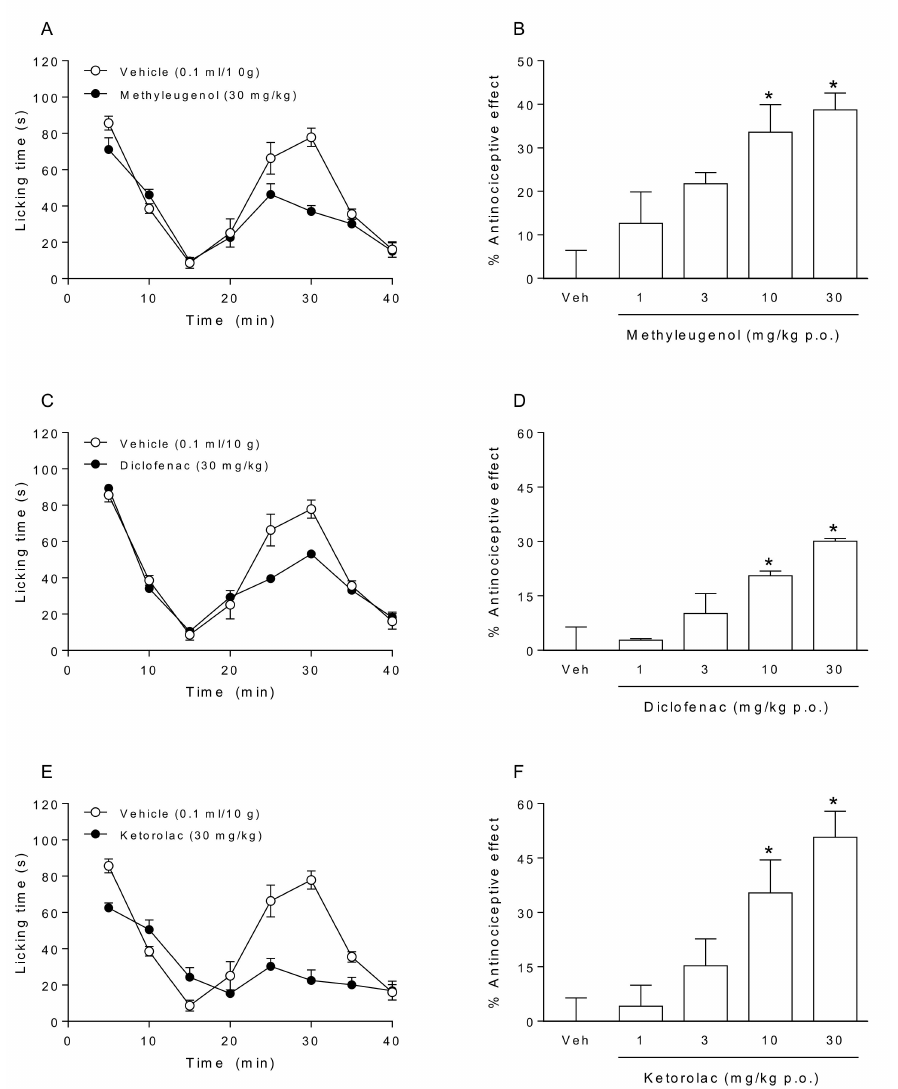
Figure 1. The time course of the antinociceptive e ff ect found for rats after receiving each compound individually: ( A ) methyleugenol (30 mg / kg), ( C ) diclofenac (30 mg / kg), and ( E ) ketorolac (30 mg / kg). Bar graph of the dose-response e ff ect on rats produced by the treatment with the vehicle (Veh), ( B ) methyleugenol, ( D ) diclofenac, or ( F ) ketorolac. The data reflect the results of phase II of the formalin test. Bars depict the mean of the percentage of antinociception ± SEM for 6–8 animals. * p < 0.05